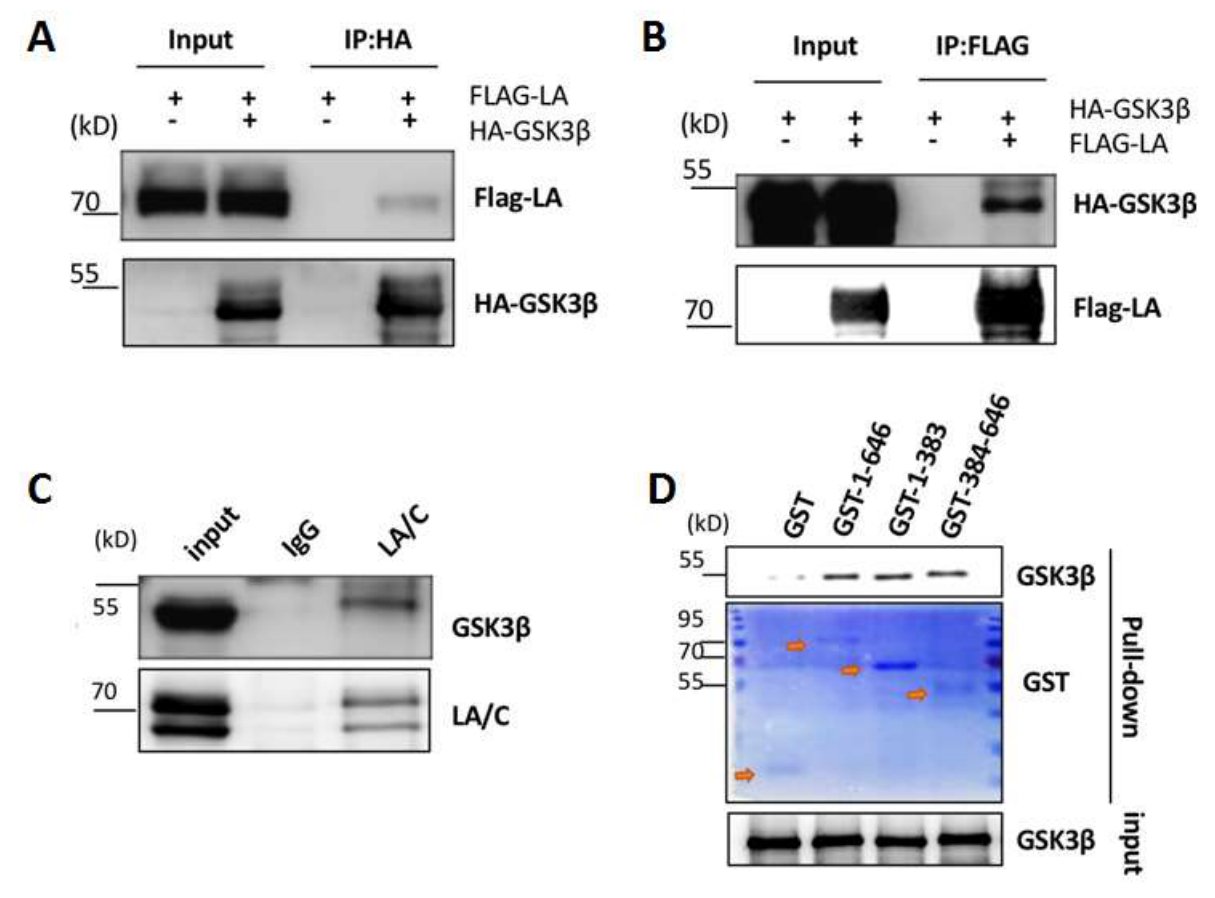
Figure 3. Direct interaction between GSK3 β and lamin A. ( A , B ) Representative co-immunoprecipitation (co-IP) and Western blots for HEK293 cells transfected with HA-GSK3 β and FLAG-lamin A, showing proteins immunoprecipitated with anti-HA ( A ) or anti-FLAG ( B ) antibodies. ( C ) Representative co-IP and Western blots showing the interaction between GSK3 β and lamin A in MEF cells in vivo; GSK3 β was pulled down by anti-lamin A/C antibodies. ( D ) GST fusions of full-length and truncated lamin A were subjected to His-GSK3 β pull down. Western blotting was performed to detect GSK3 β protein levels and Coomassie brilliant blue (CBB) staining was performed to detect GST, GST-lamin A, and GST-lamin A mutant-tagged proteins; red arrows indicate the corresponding protein bands.